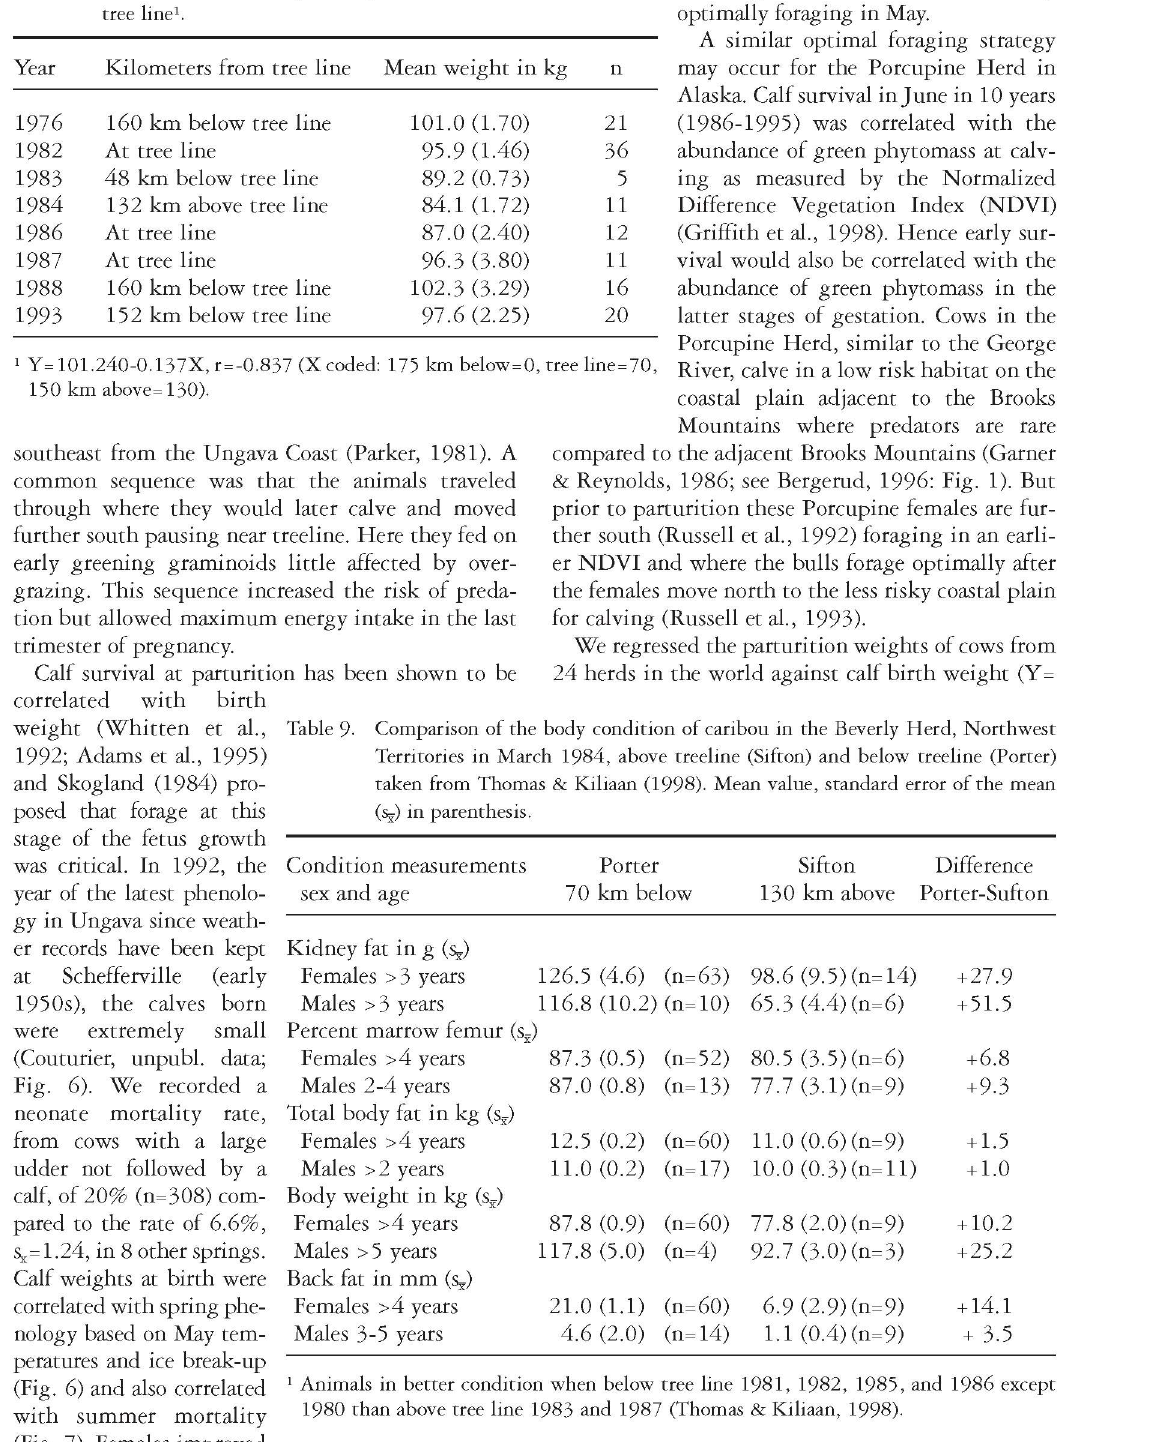
Table 8. Weight (mean and standard error of the mean in parenthesis) of females in March or April compared to their location relative to tree line 1 .